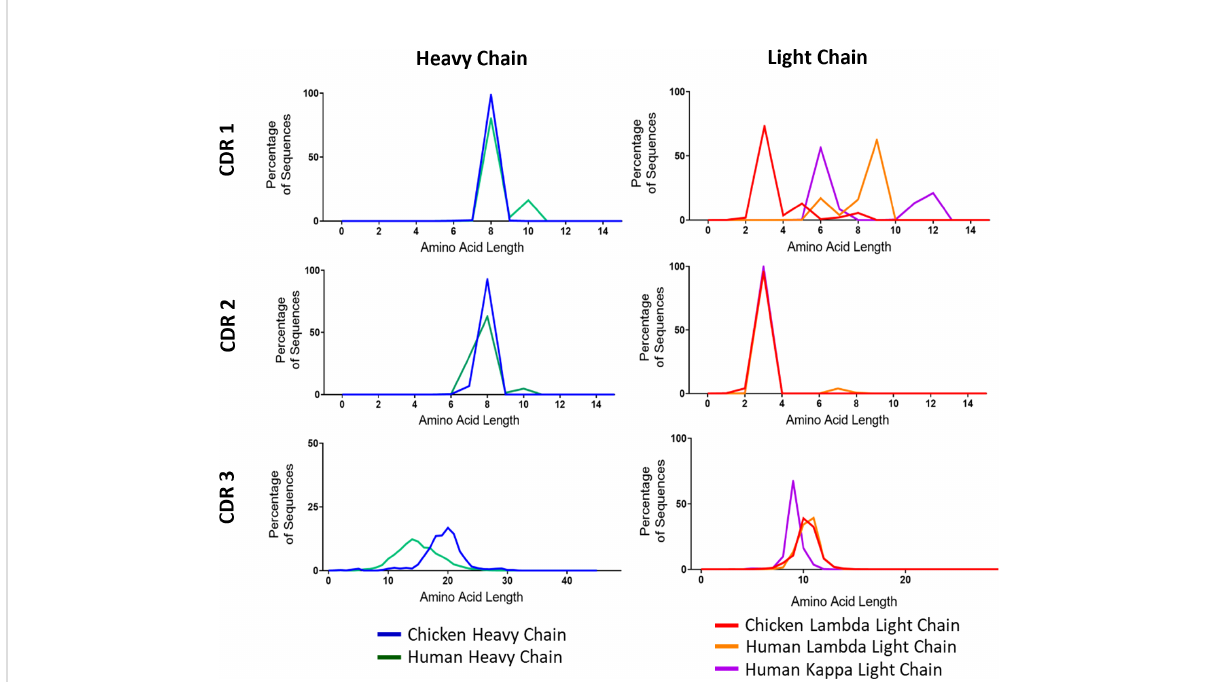
FIGURE 3 Distribution of amino acid lengths in all three complementarity-determining regions (CDRs) of both the immunoglobulin heavy and light chains. N: human heavy chain sequences = 396,506, chicken heavy chain sequences = 98,387, chicken lambda light chain sequences = 38,244, human lambda light chain sequences = 43,000, and human kappa light chain sequences = 158,668.